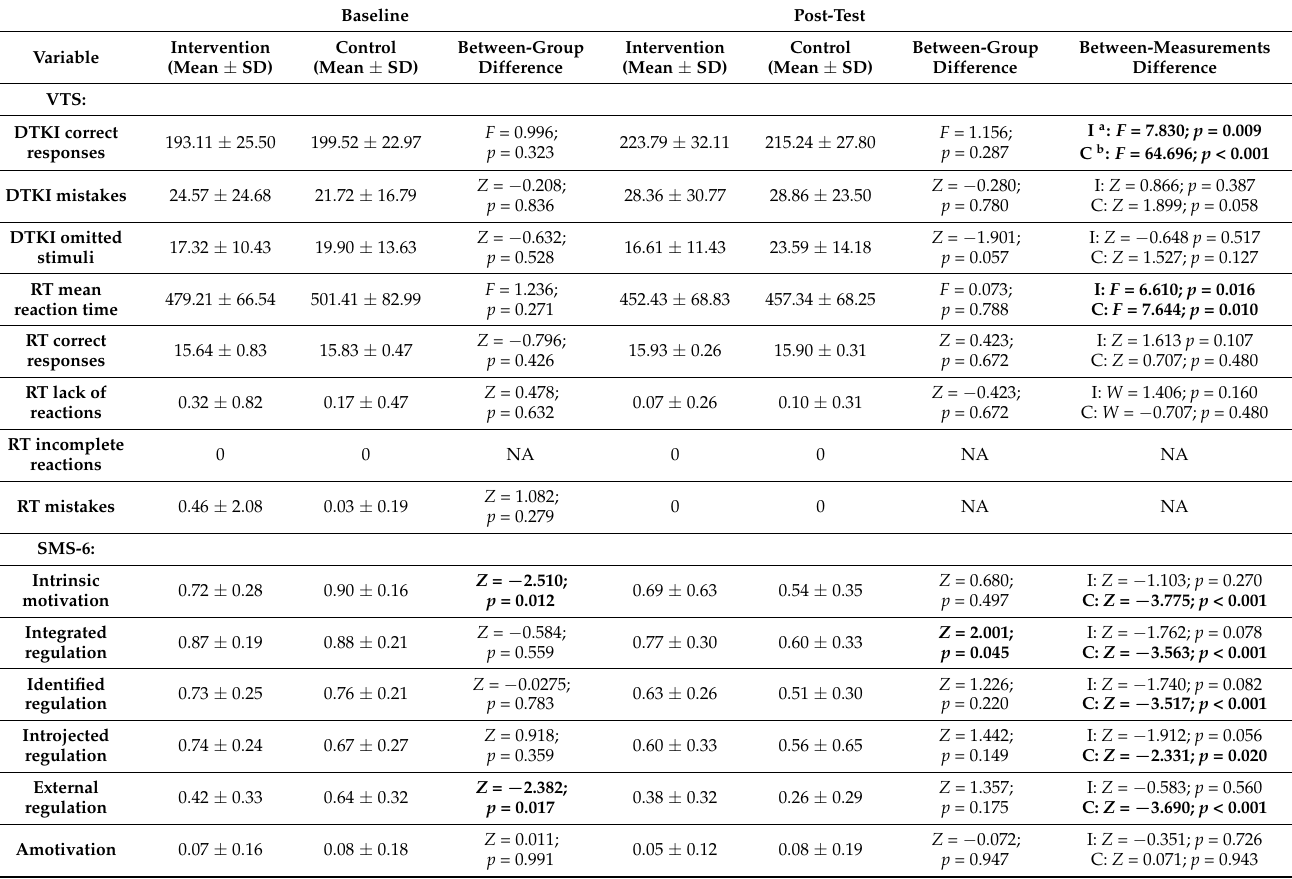
Table 2. The differences in the mean scores obtained for the VTS and SMS-6 variables between groups (intervention vs. control) and between measurements (baseline vs. post-test). Baseline Post-Test